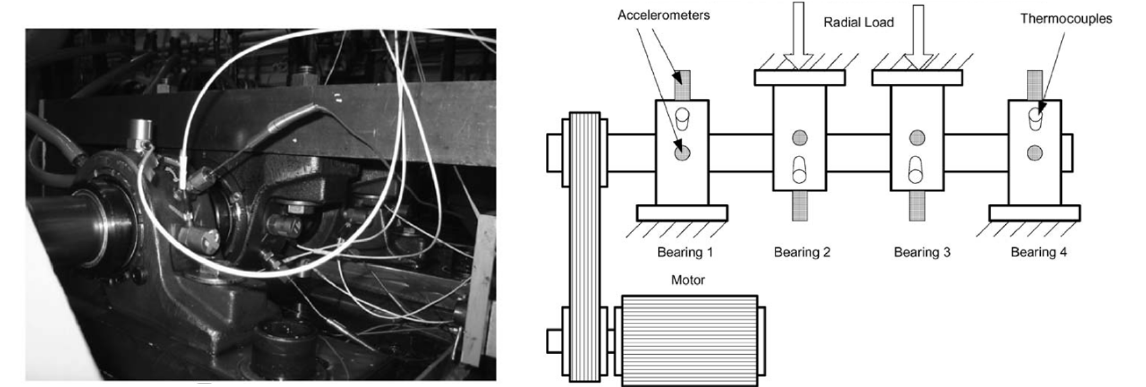
Figure 3. Experimental Apparatus (Bearing Test Ring) adapted from